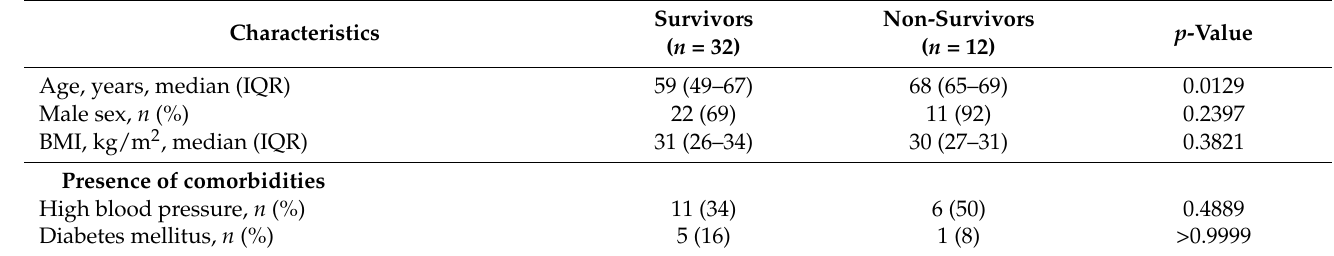
Table 2. Characteristics of survivors and non-survivors ICU COVID-19 A-I, Apo A-II, Apo A-IV, TC, LDL-C, Apo H, Apo M, TG and Apo C-I. This is consistent